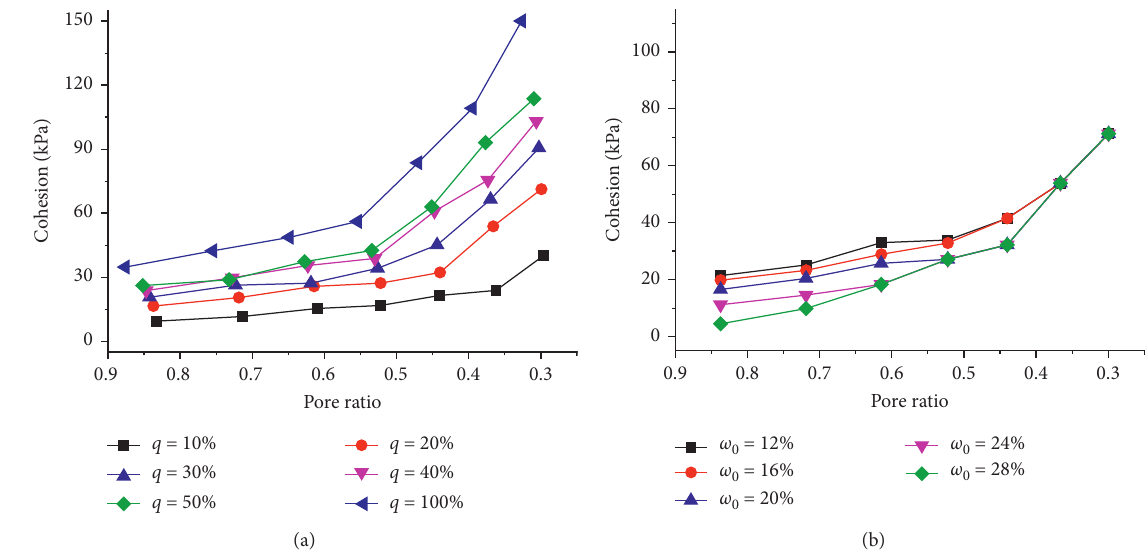
Figure 10: Variation of cohesion with pore ratio. (a) At different clay contents. (b) At different initial water